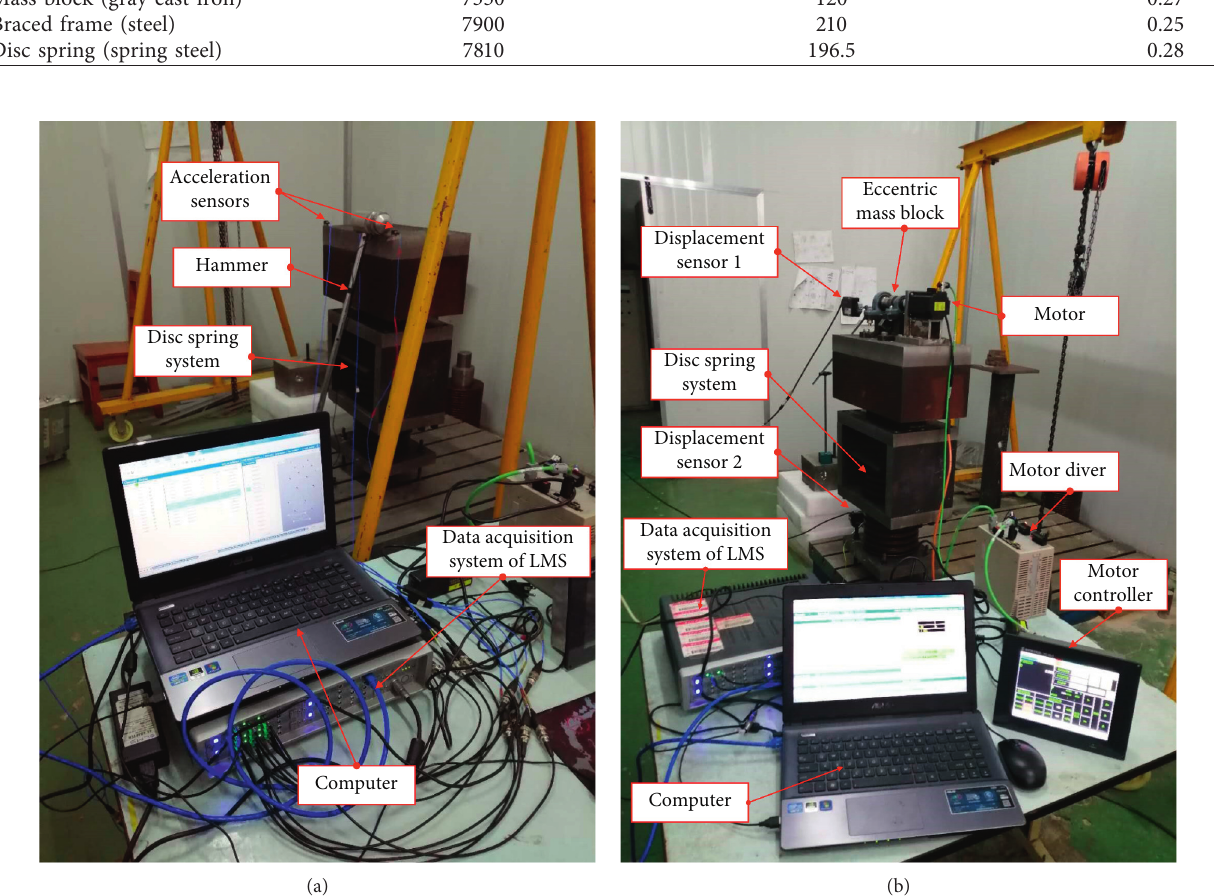
Figure 5: Specific experimental equipment and scenarios: (a) modal test and (b) amplitude